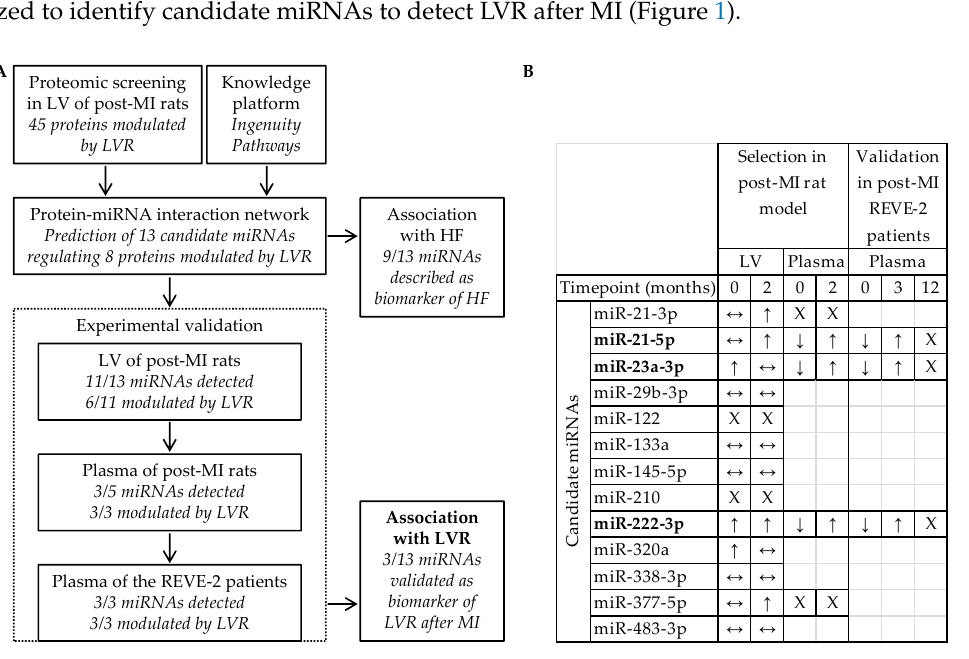
Figure 1. Identification of miR-21-5p, miR-23a-3p and miR-222-3p to detect left ventricular remodeling (LVR) after myocardial infarction (MI) and to predict heart failure (HF). ( A ) Design and ( B ) experimental selection and validation of the 13 candidate miRNAs predicted from the proteomic data obtained in LV of post-MI rats by the Ingenuity Pathway knowledge platform. Quantification of candidate miRNAs in LV and in plasma of post-MI rats at 7 days (Timepoint 0) and at 2 months and in plasma of REVE-2 patients at baseline (Timepoint 0), 3 month and 12 months after MI was published elsewhere [10]. ↑ and ↓ respectively indicate a significant increase and decrease of miRNAs ( p < 0.05) detected between sham- and post-MI rats/between patients with no and high LVR, ↔ indicates no modulation, X indicates a lack of detection. MiRNAs remaining after the validation process are in bold.